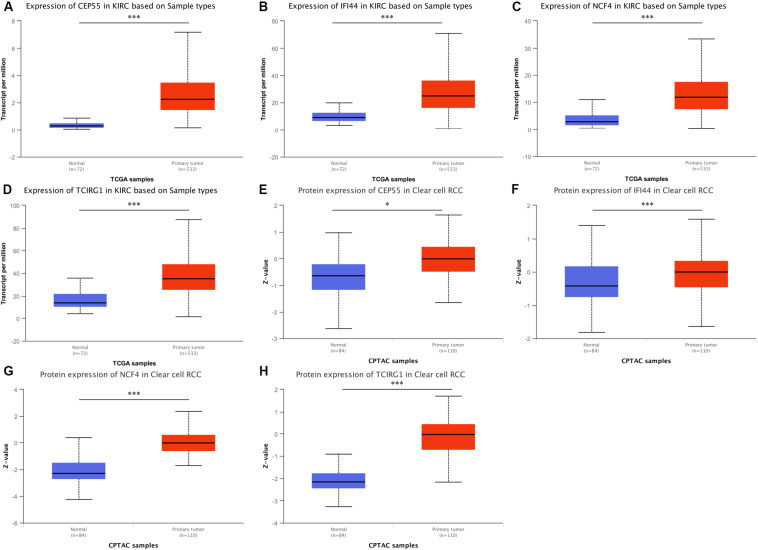
(A–D) Expression pattern of CEP55, IFI44, NCF4, and TCIRG1 between ccRCC and adjacent normal tissue. (E–H) Corresponding protein level between ccRCC and adjacent normal tissue. *P < 0.05 and ***P < 0.001 respectively.